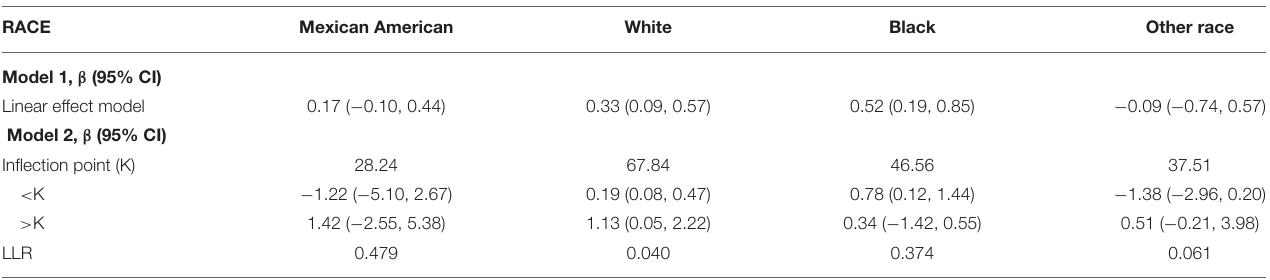
TABLE 4 | Threshold effect analysis of METS-IR and serum ferritin (ng/ml) stratified by race. RACE Mexican American White Black Other race Model 1, β (95%